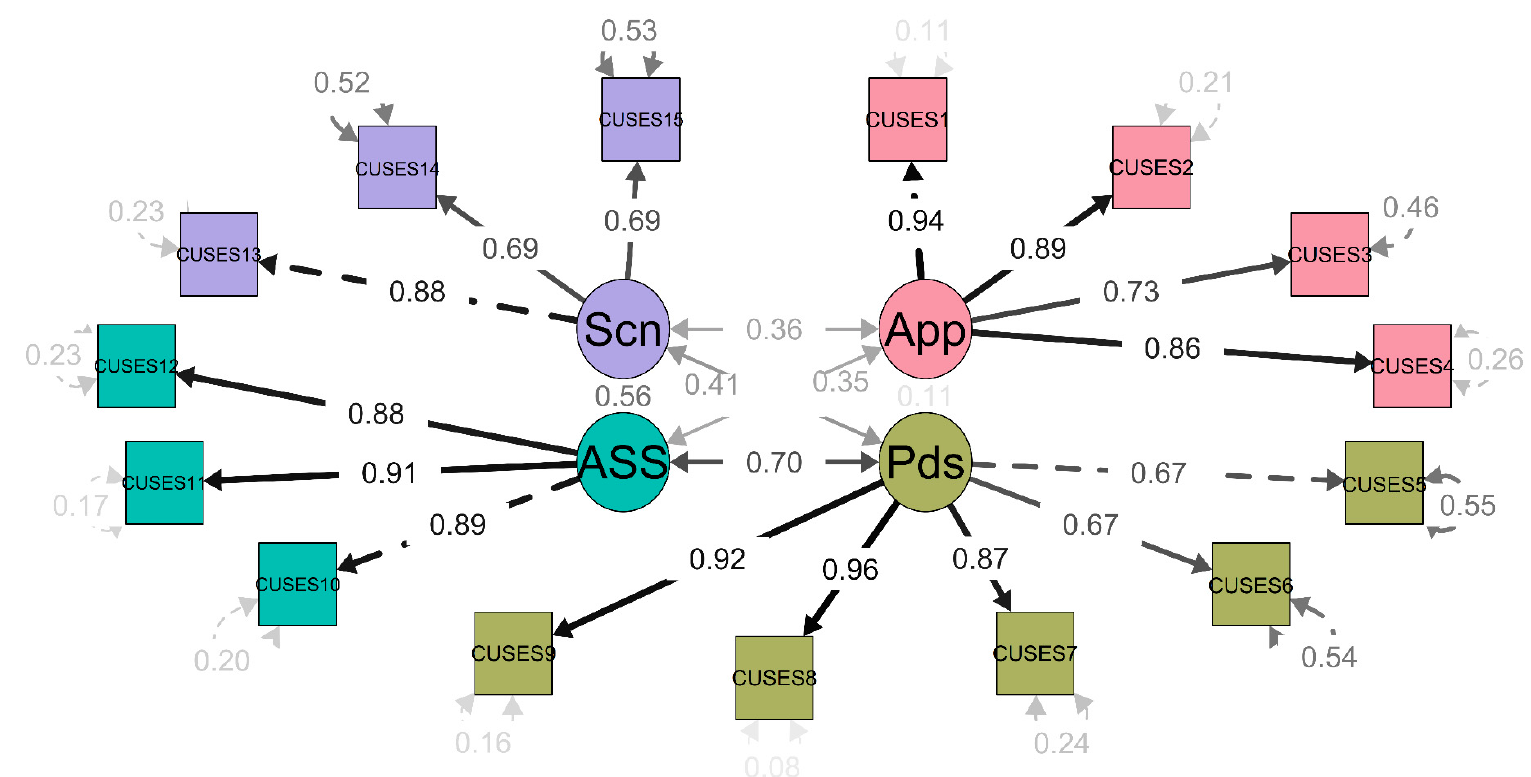
Figure 1. Confirmatory factor analysis (CFA) path diagram on four proposed dimensions. Standardized weights are presented. App = appropriation; Pds = partner’s disapproval; Ass = assertiveness; Scn = self-control.